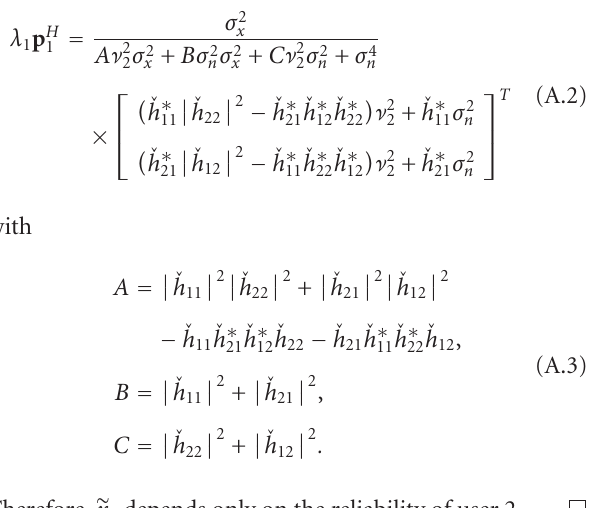
Figure 5: Convergence of the iterative system for four-coordinated users with two external crosstalk